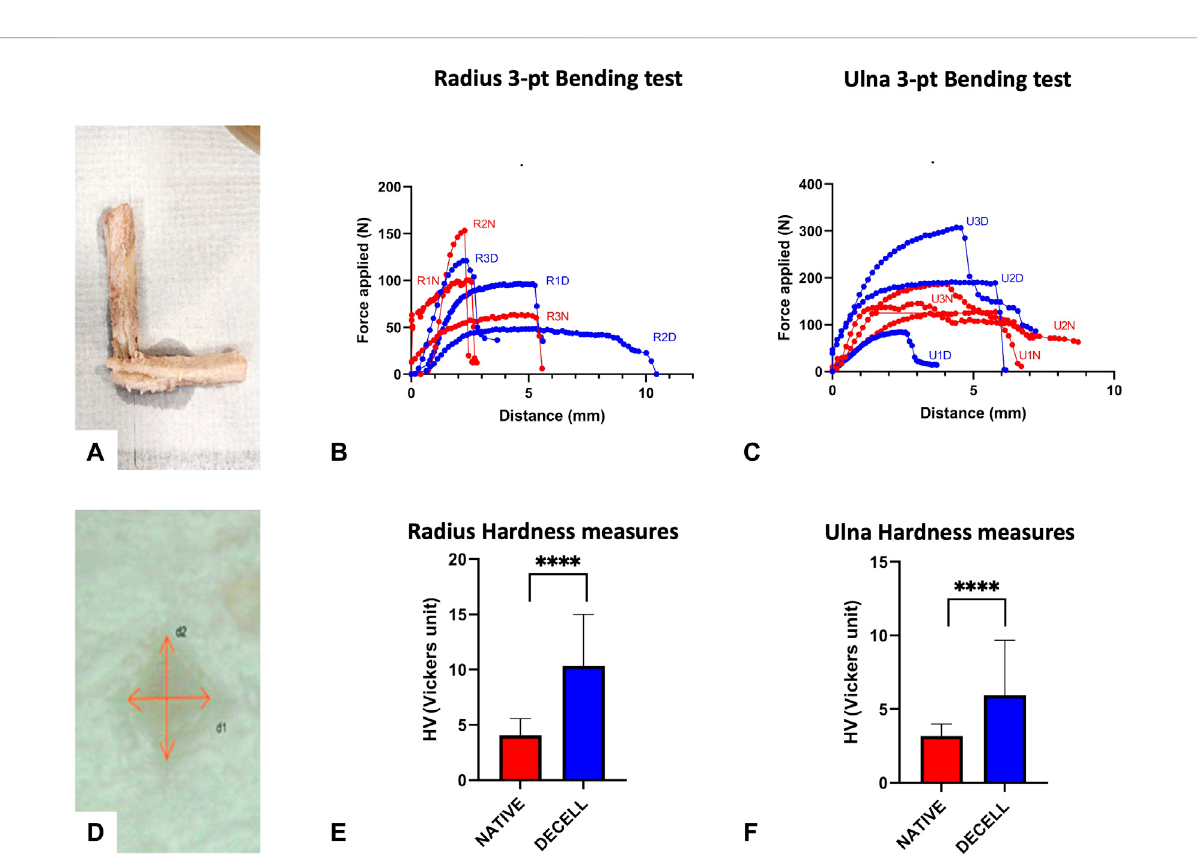
FIGURE 6 MechanicalTestingboneECM. (A – C) :Bendingtestperformedonradialandulnarshaft.Visualizationofthefracture (A) oftherodaftersuccessfulbending test.Radius (B) andulna (C) 3-ptbendingcurves(red=native,blue=decellularized)achievedwhileplottinginagraphtheforce(N) versus verticaldisplacement (mm). (D – F) Hardness test on radial and ulnar bone segments. Visualization of the tip print on the mounted sample (D). Radius (E) and ulna (F) hardness measures in native (red) and decellularized bone ECM (blue), Hardness values (HV) were expressed in Vicker units ± SD (n = 3 each; **** p < 0.0001)